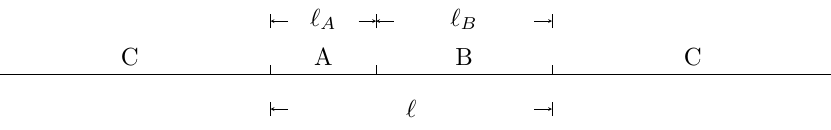
Figure 2 . The space partition in the 1+1d CFT. We take subsystem A, B to be contiguous with size ‘ A and ‘ B . In general we take A to be smaller: ‘ A much larger than ‘ = ‘ A + ‘ B , so that thermalization will take place at late